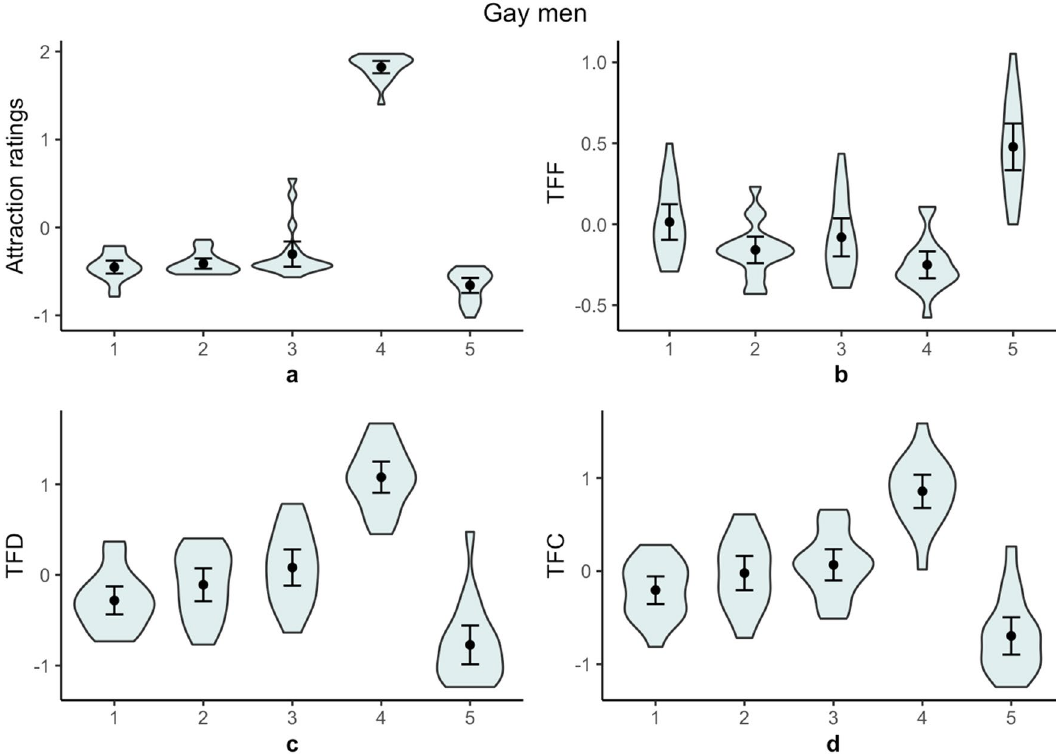
Figure 2. Gay men’s ( a ) standardized attraction ratings, ( b ) standardized time to first fixation (TFF), ( c ) standardized total fixation duration (TFD), and ( d ) standardized total fixation count (TFC) by stimuli category. 1 = cisgender women, 2 = feminine trans individuals with breasts, 3 = feminine trans individuals without breasts, 4 = cisgender men, 5 = bonobos. Points indicate group mean. Capped lines show 95% confidence intervals. Shapes show the density of data